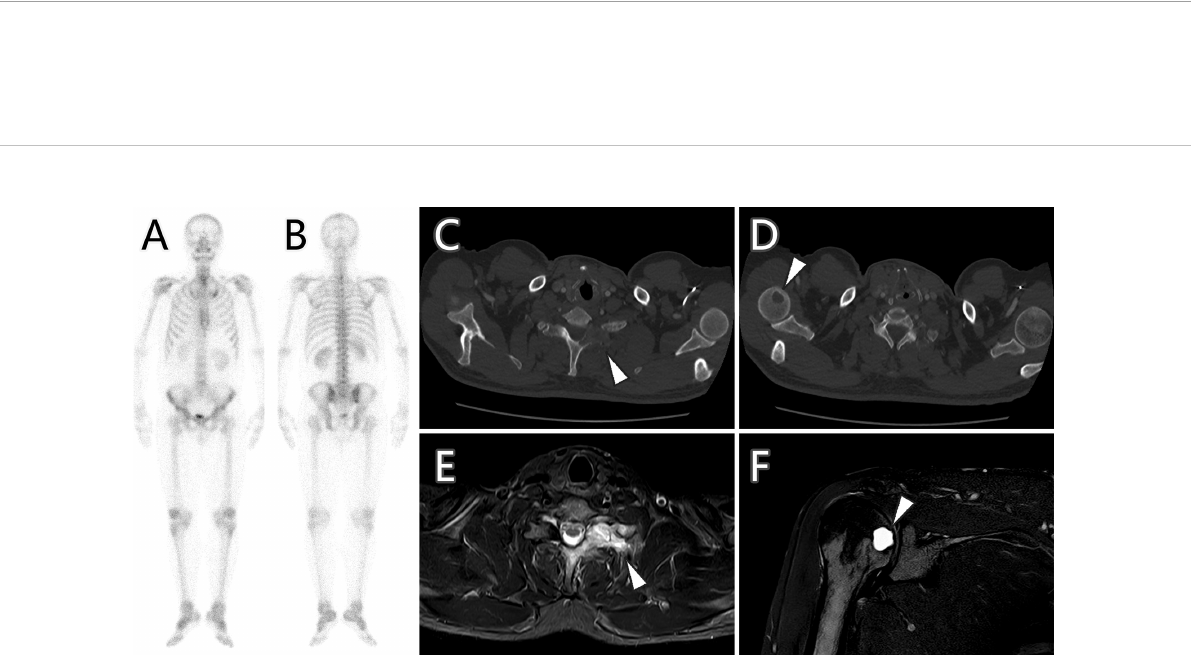
FIGURE 4 Bone scan, CT imaging, and MR imaging of bone metastases (arrowhead) after 6 months of treatment. Bone scan (A, B) showed no increased radioactive uptake, while CT imaging (C, D) demonstrated the metastases as osteolytic lesions with hyperintensity in MR spectral attenuated inversion recovery (SPAIR) sequence images (E, F) .